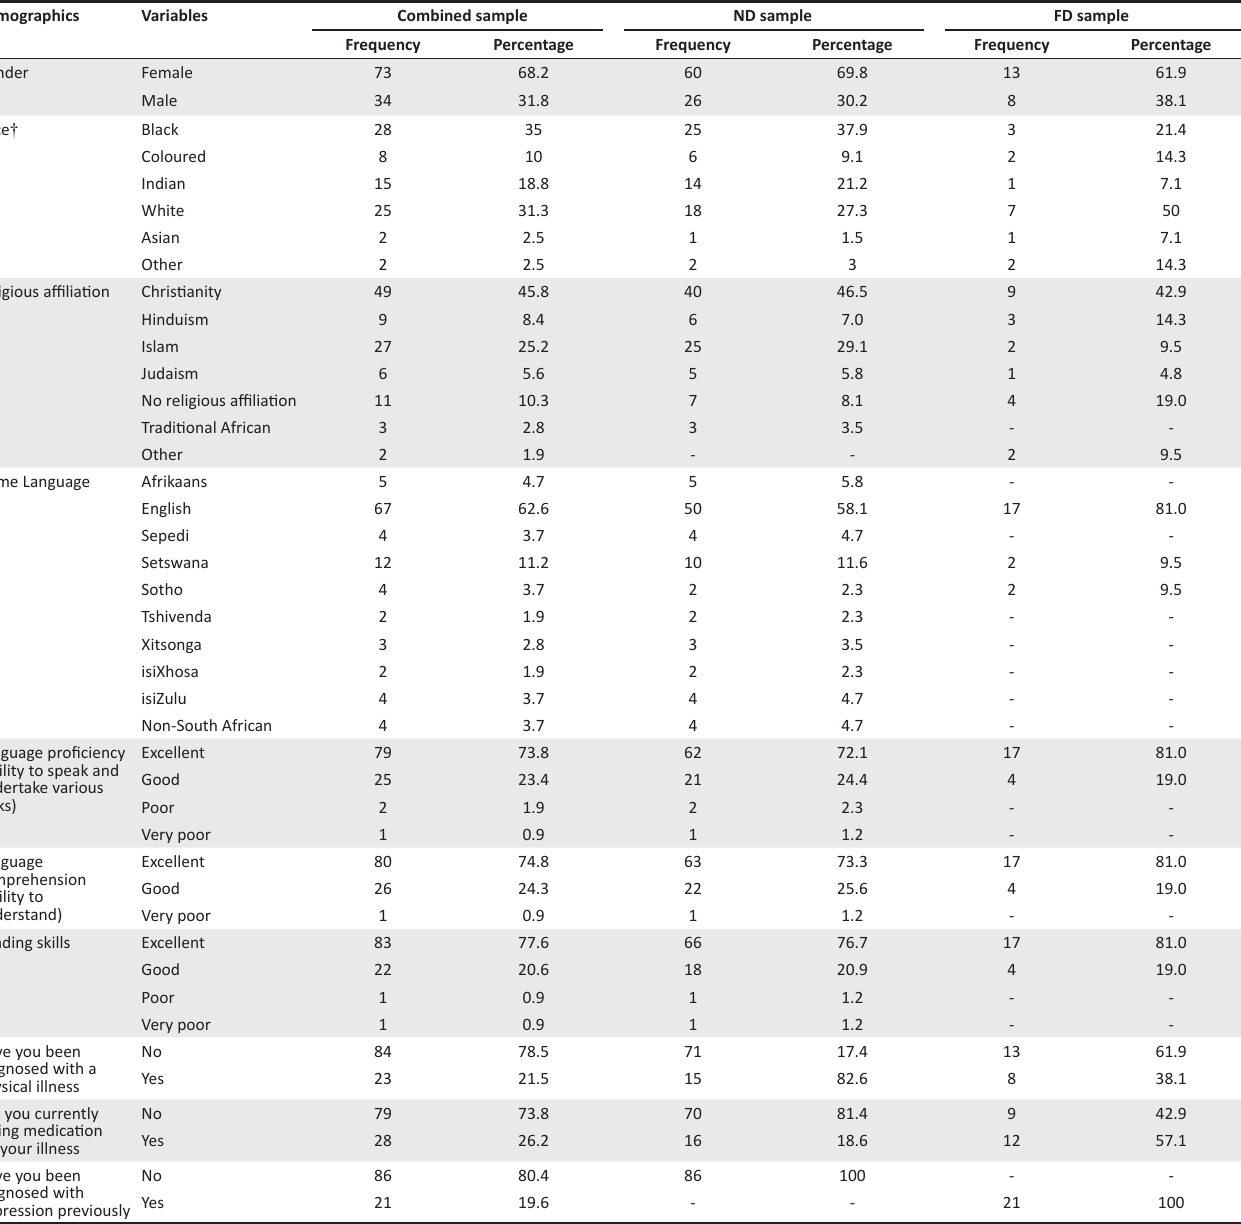
TABLE 1: Combined, No diagnosis and formally diagnosed sample demographics. Demographics Variables